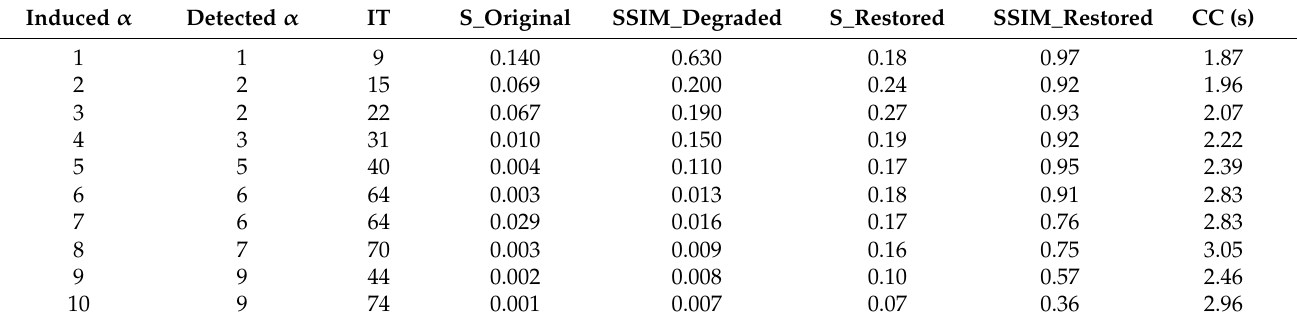
Table 1. Results of the algorithm testing in simulated images. Induced glare angle (Induced α ). Detected glare angle: (Detected α ). Optimal iteration number. (IT); Original image sharpness: (S_Original) Original. SSIM of the degraded image: (SSIM_Degraded). Sharpness of the restored image (S_Restored). Restored SSIM: (SSIM_Restored). Computational costs: